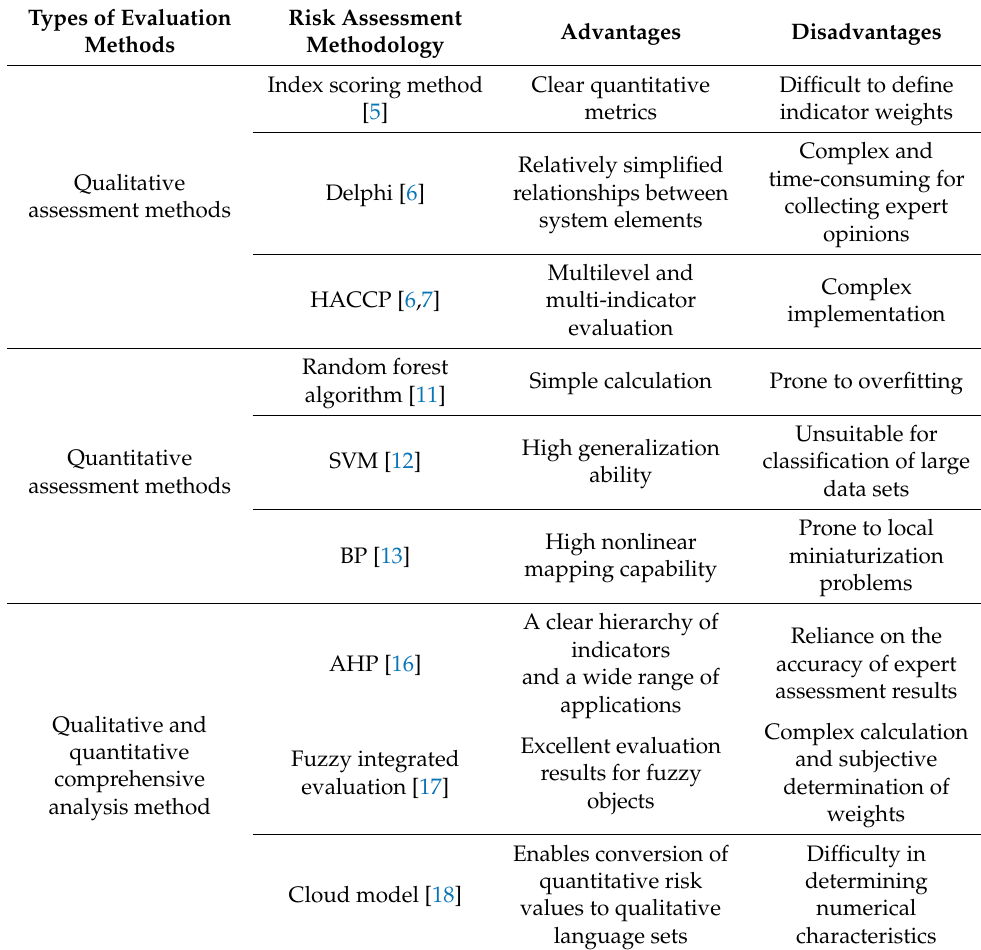
Table 1. Comparison of advantages and disadvantages of various risk evaluation